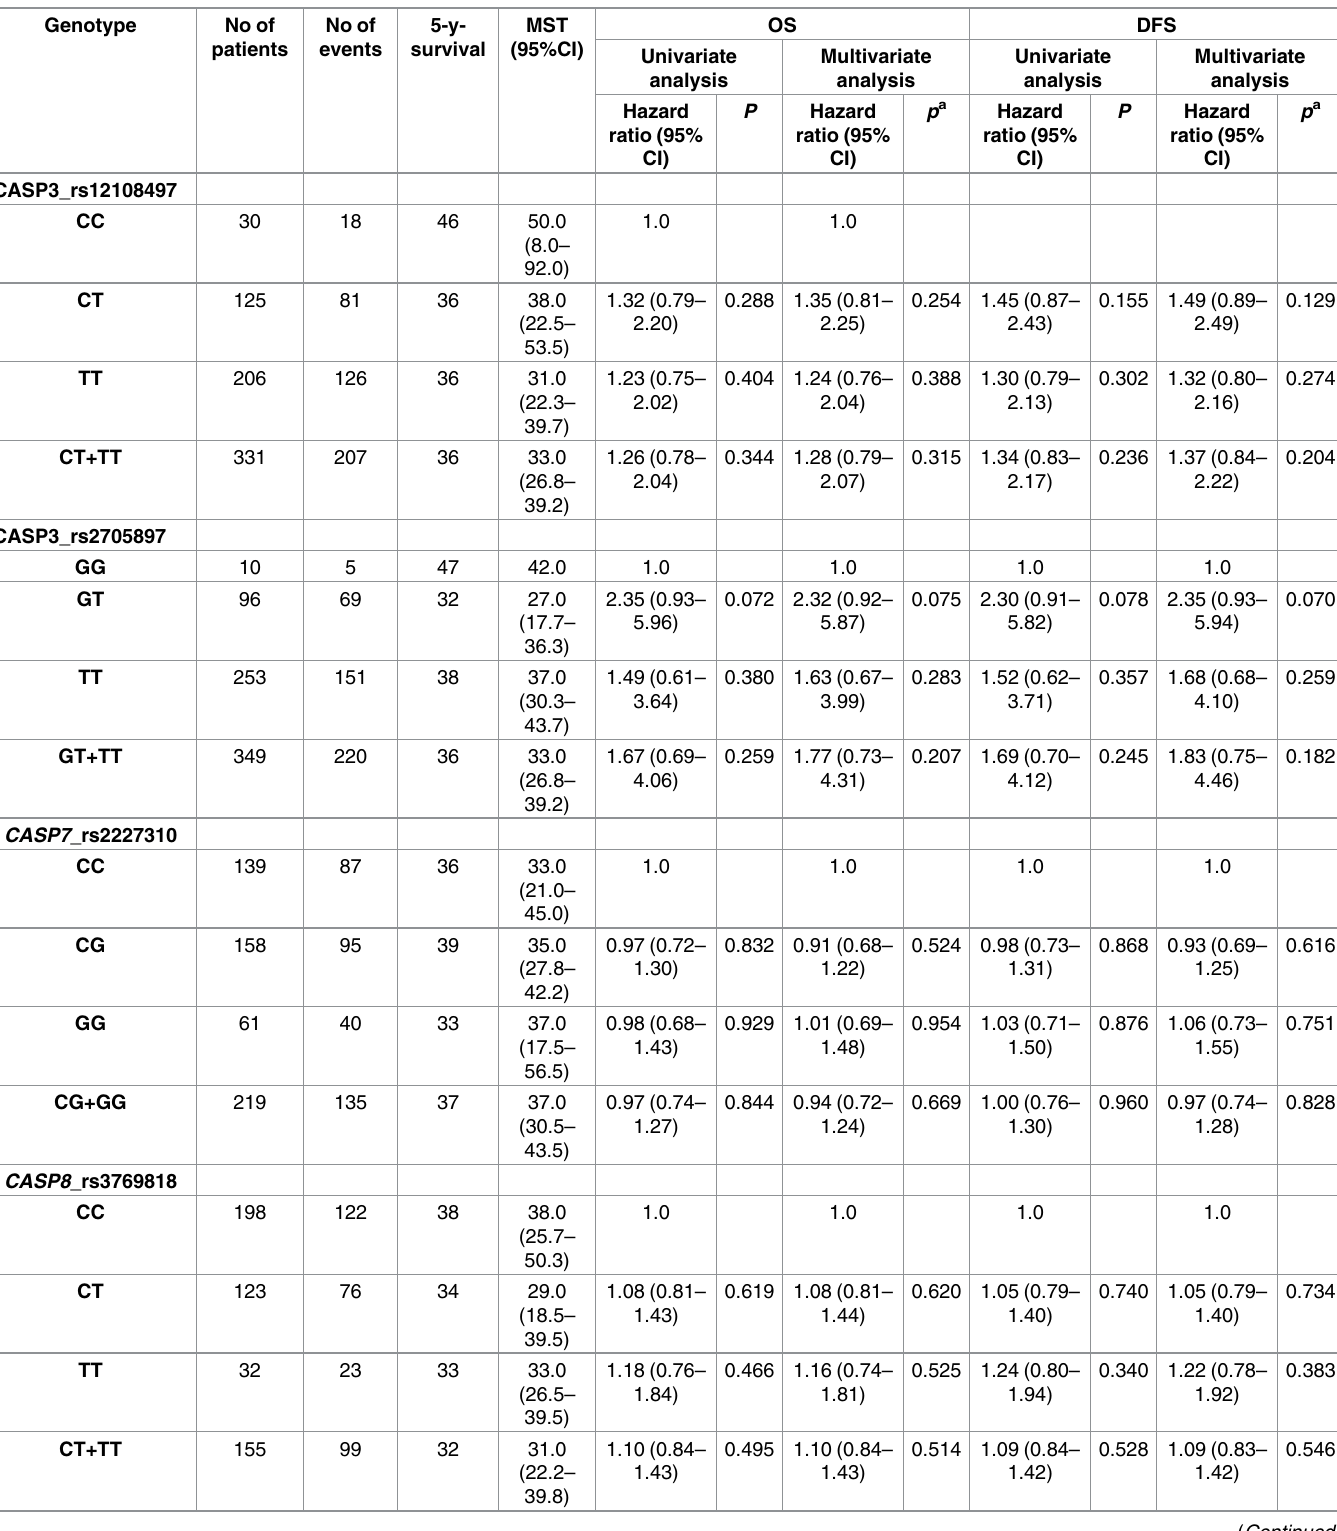
Table 3. Univariate and multivariate Cox regression analysis of genotypes in HCC